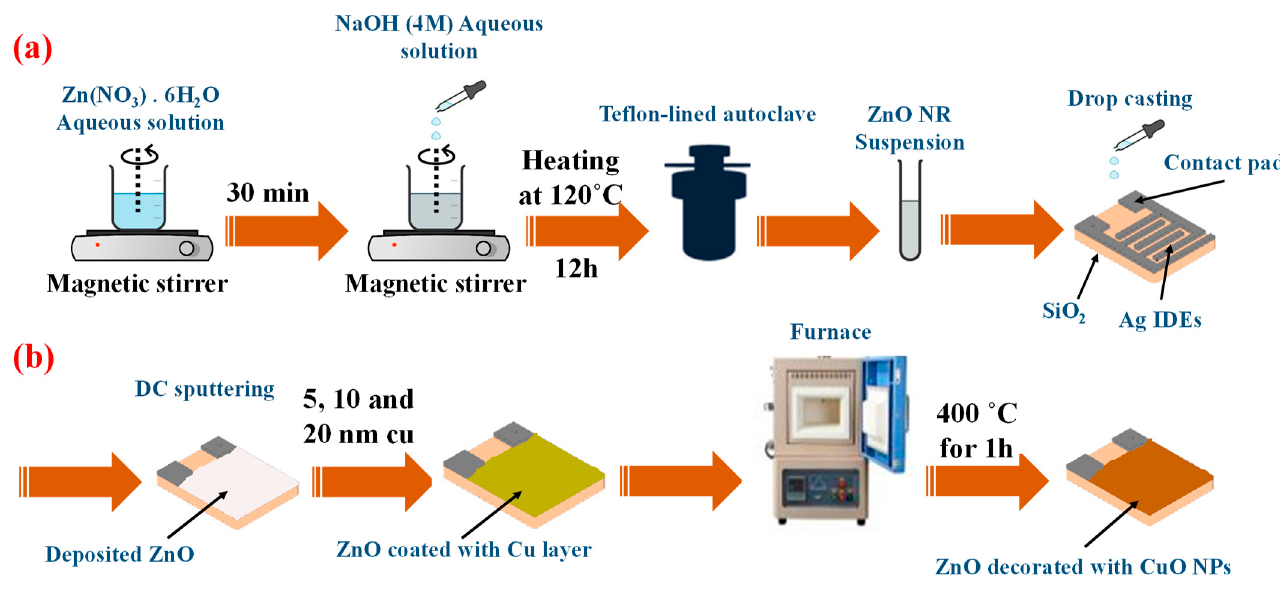
Figure 1. Schematic of preparation of ( a ) pristine ZnO NRs and ( b ) CuO-decorated ZnO NRs.